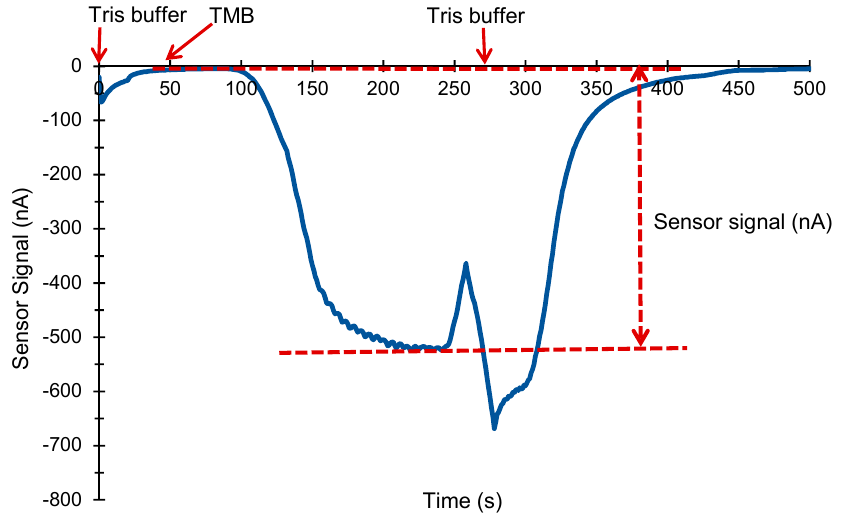
Figure 2. The current response of an individual electrode at − 0.1 V potential is recorded uninterruptedly during the consequent injections of buffer and TMB substrate to the HRP-bound electrode to obtain a sensorgram. The flow rate of the device is 50 µL min − 1 during the injections.